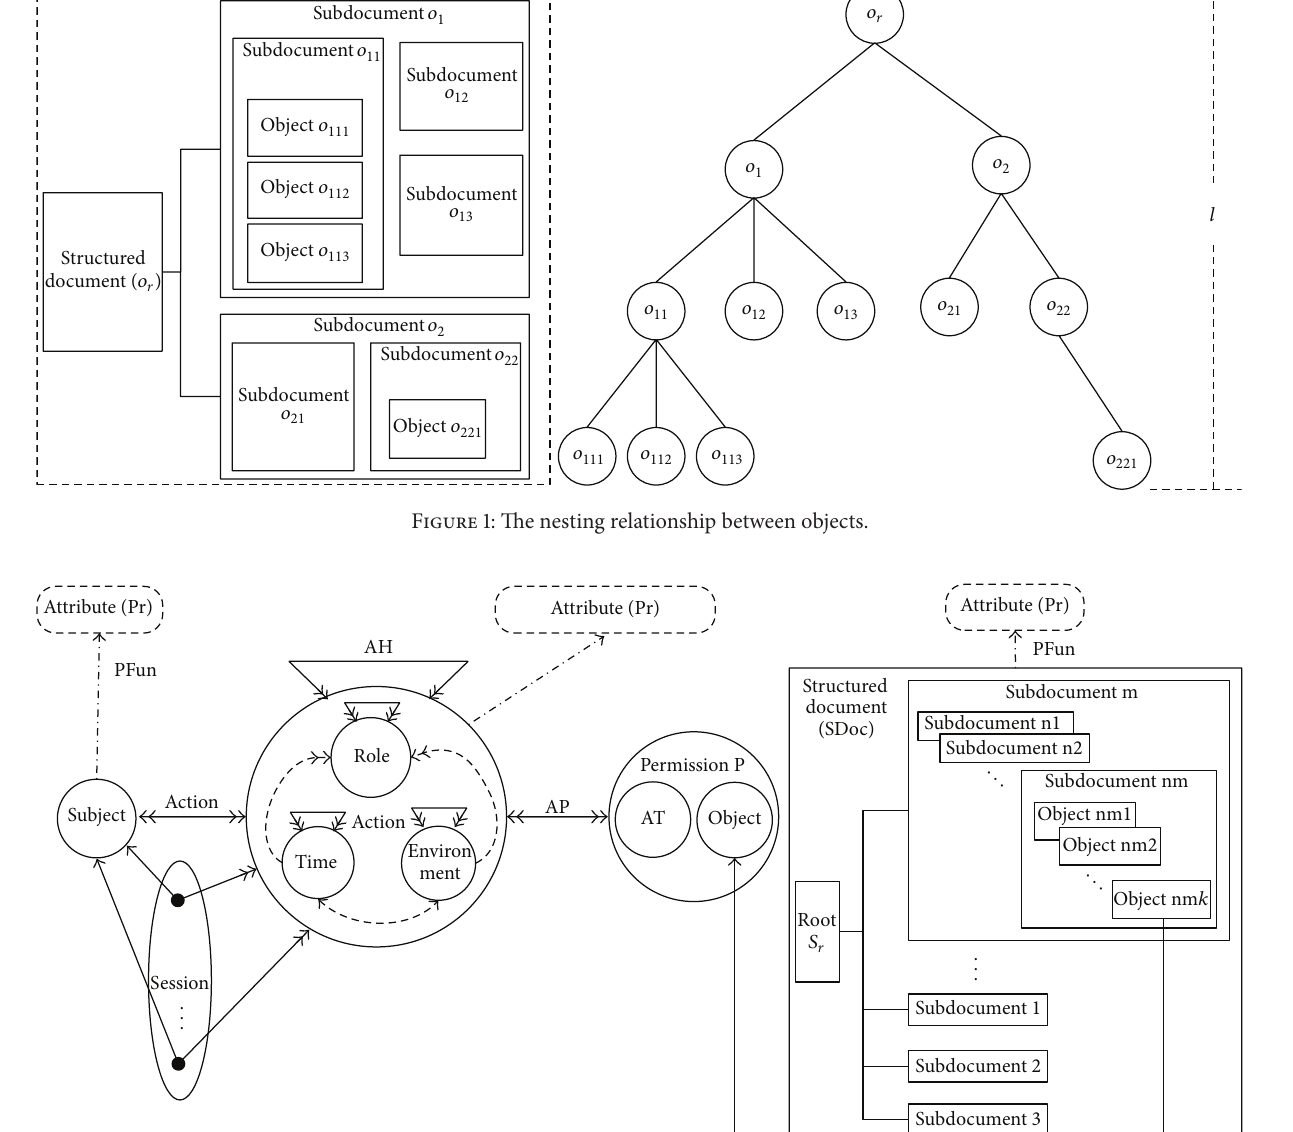
Figure 2: The action-based fine-grained access control model for structured document. Figure 2. The action hierarchy (AH) and